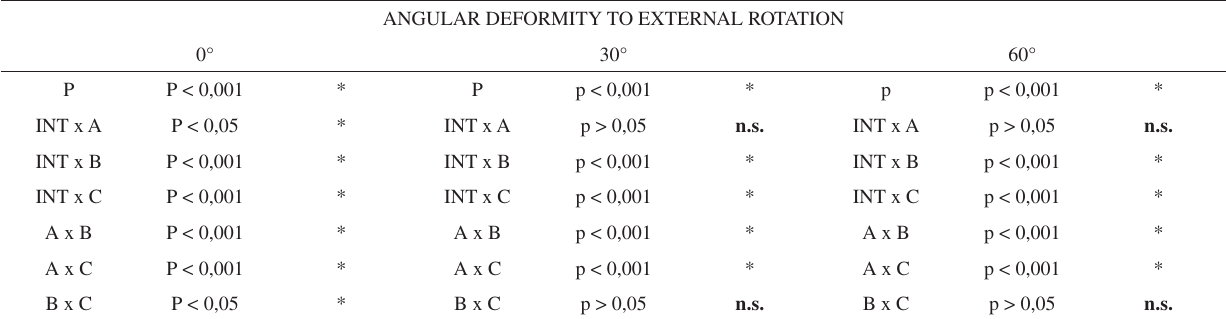
Table 5 - Comparative table and p values for the situations in external rotation testing to angular deformity. ANGULAR DEFORMITY TO EXTERNAL ROTATION